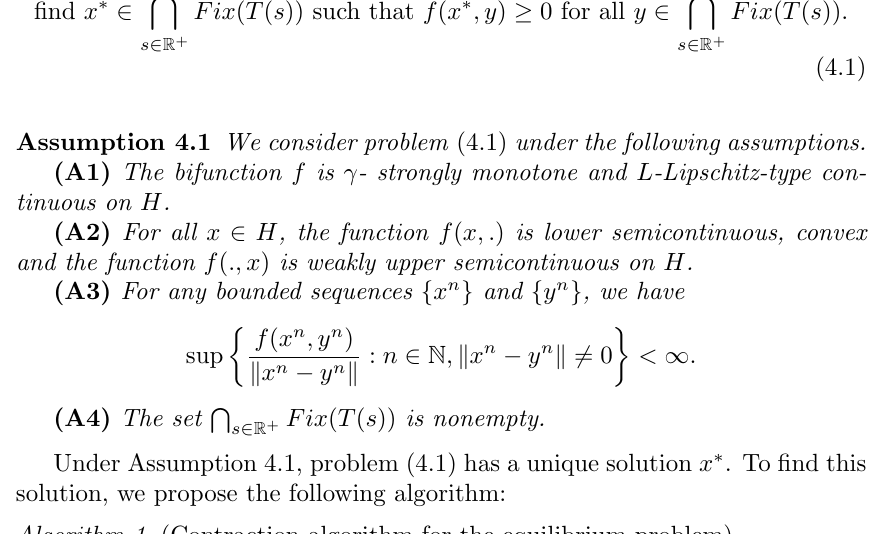
Algorithm 1. (Contraction algorithm for the equilibrium